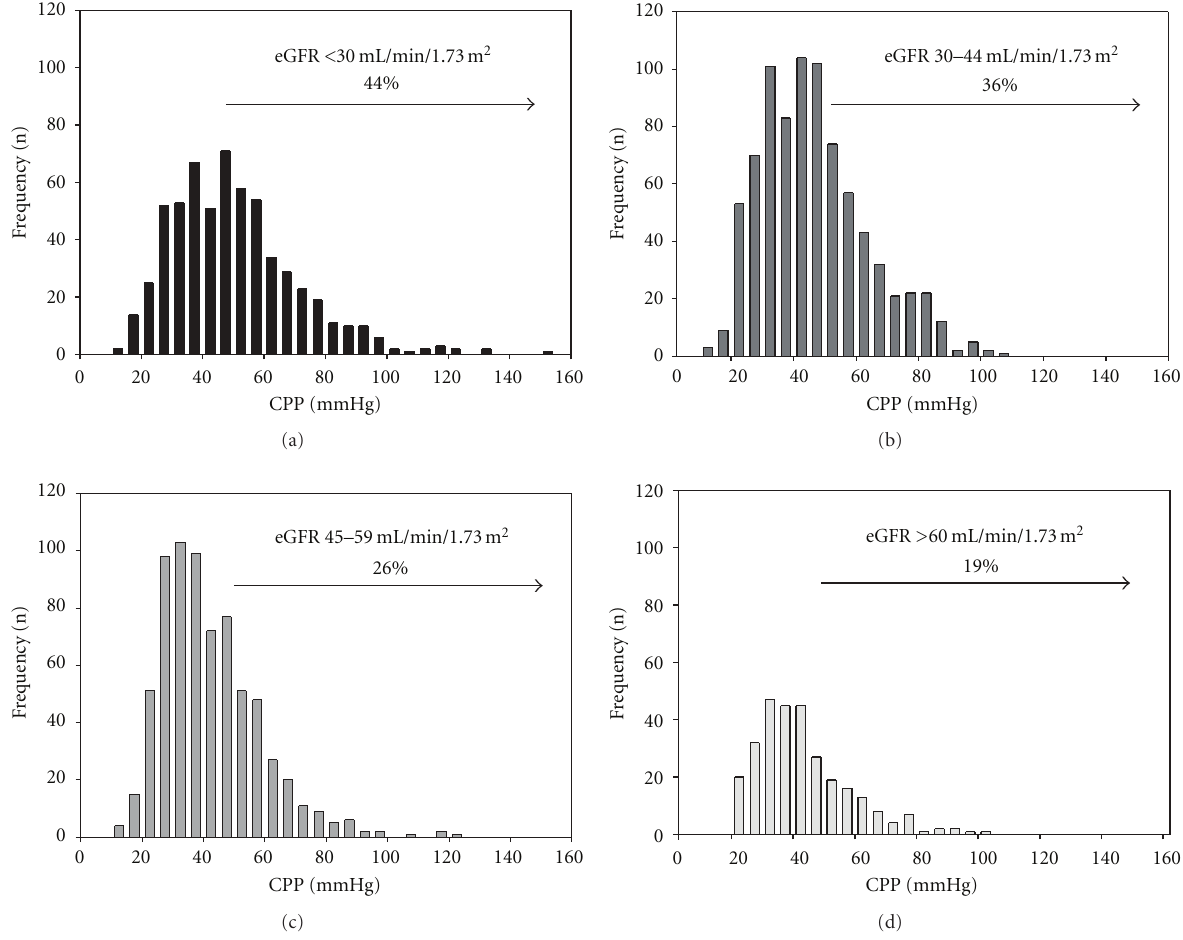
Figure 5: Increasing prevalence of central pulse pressure values > 50 mmHg among 2531 participants in the Chronic Renal Insu ffi ciency Cohort (CRIC) (redrawn from